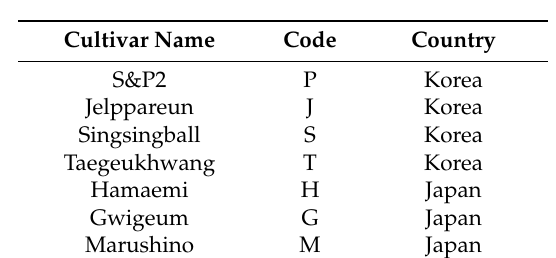
Table 1. List of seven onion cultivars collected from Korea and